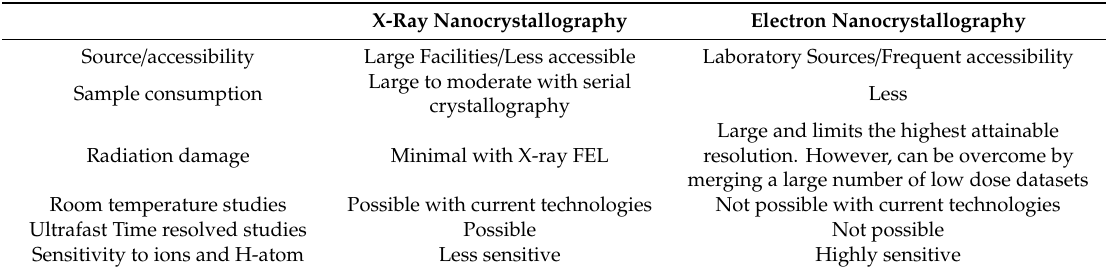
Table 2. Comparison of X-ray and electron